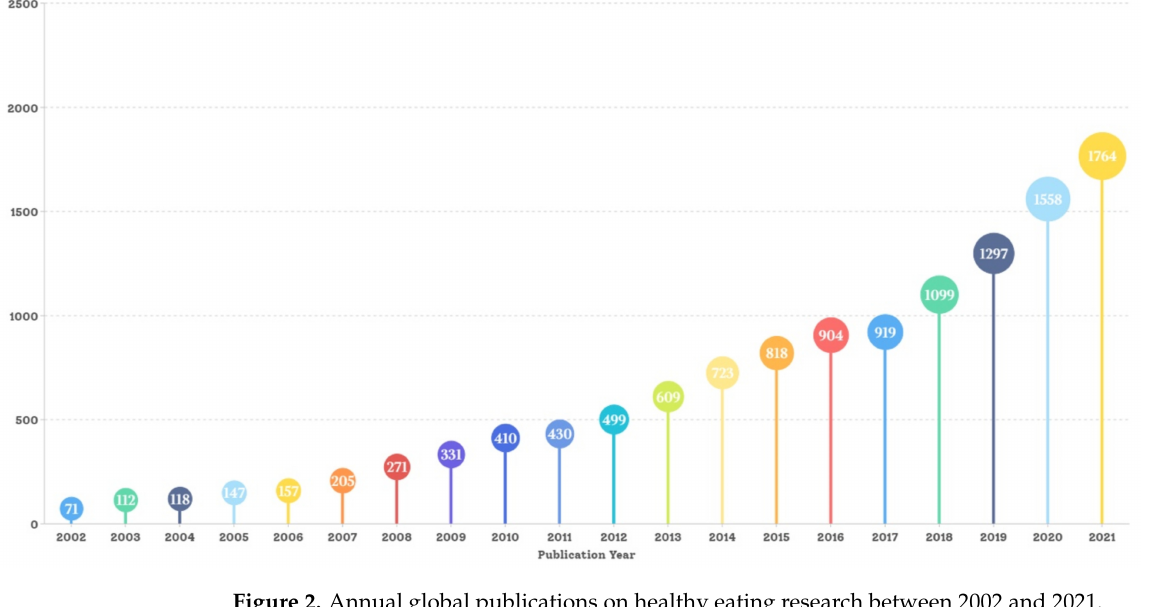
Figure 2. Annual global publications on healthy eating research between 2002 and